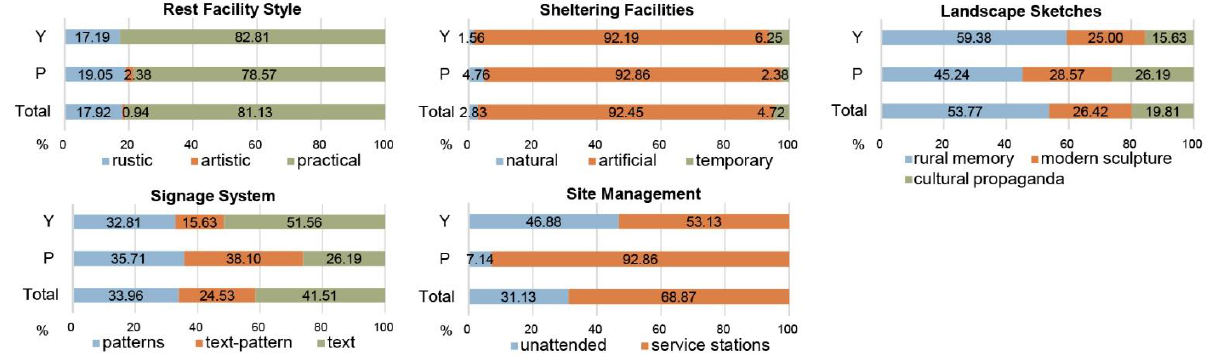
Figure 7. Survey statistics of respondents ’ facilities allocation preferences.